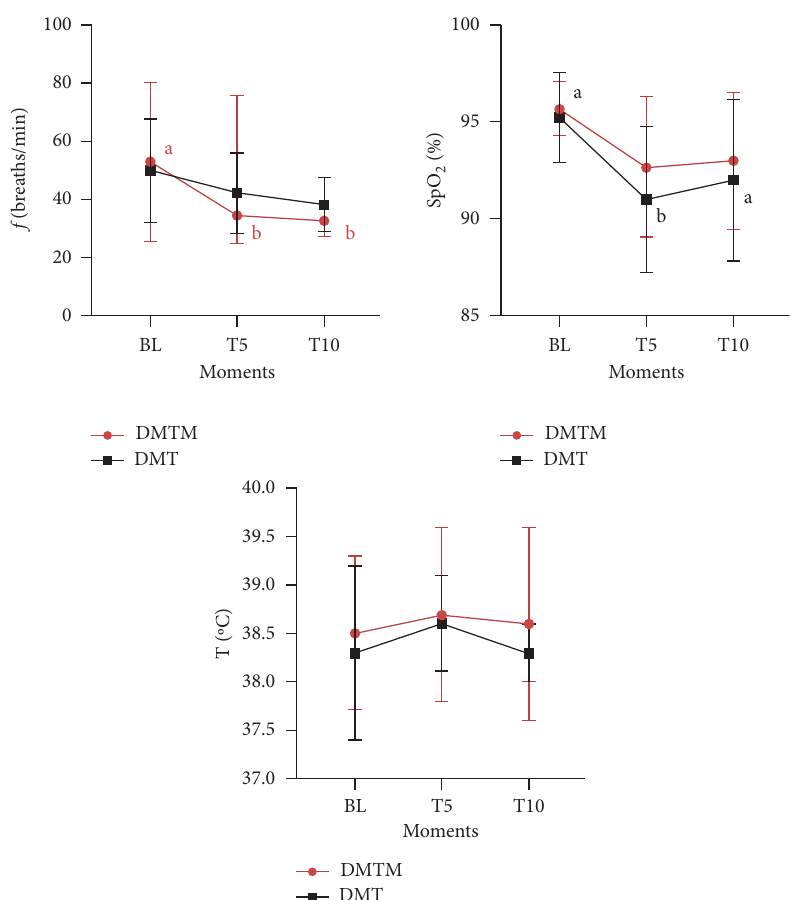
Figure 2: Values of respiratory rate (f), hemoglobin peripheral saturation thorough oxygen (SpO felines sedated with the association of dexmedetomidine (7.5ug/kg) and methadone (0.3mg/kg) (DMT, n � 9) or dexmedetomidine (5ug/ kg), methadone (0.3mg/kg), and midazolam (0.3mg/kg) (DMTM, n � 9), both by the intramuscular route. Values are presented as mean ± standard deviation. a, b: diferent lowercase letters indicate signifcant diferences between moments inside the same group according to Tukey test ( p < 0 .